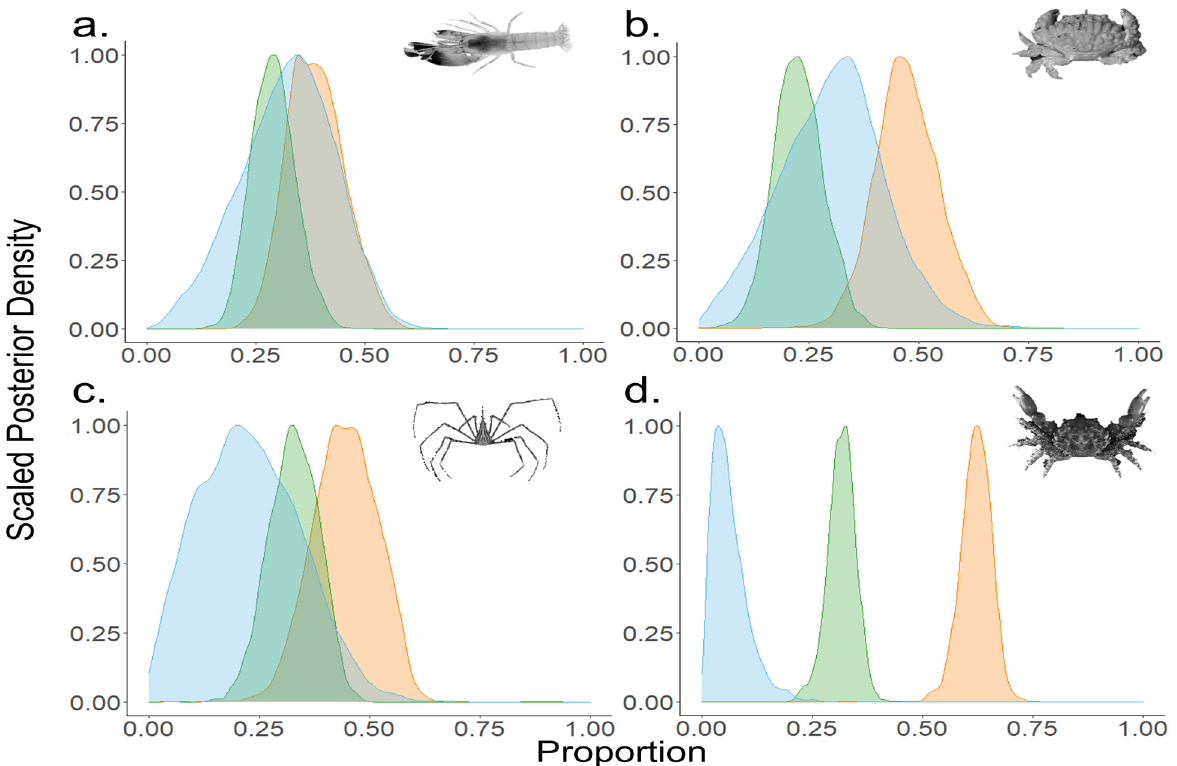
Figure 5. Relative contribution estimates of the three dominant primary producers [POM (blue), BMA/seagrass (orange), mangrove (green)] for the four most prevalent invertebrate species. Plots represent outputs from MixSIAR models. Invertebrate species are ( a ) snapping shrimp, ( b ) rubble crab, ( c ) arrow crab, and ( d ) clinging crab.